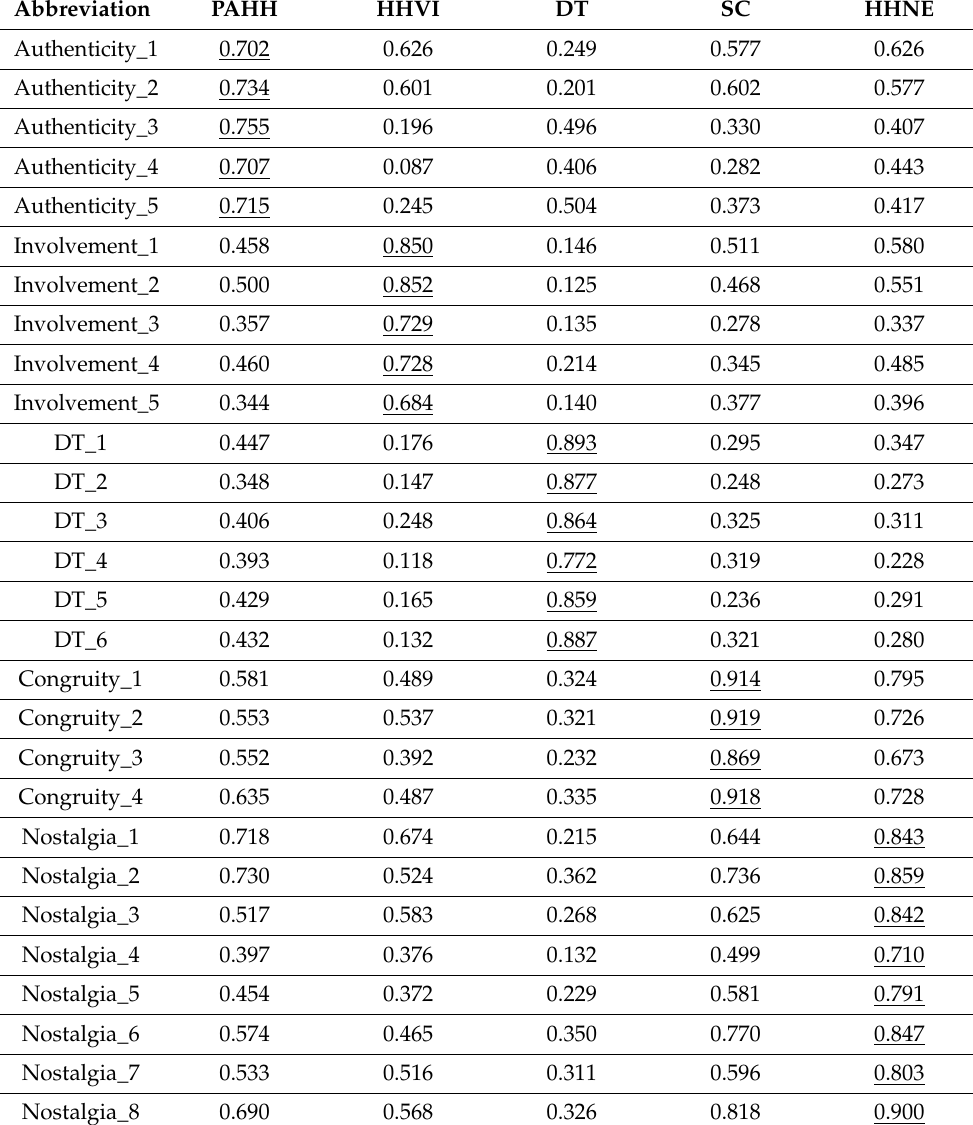
Table 2. Cross loading